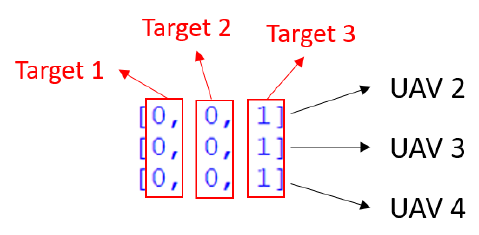
Figure 16. Initialized capability matrixes of all six UAVs.